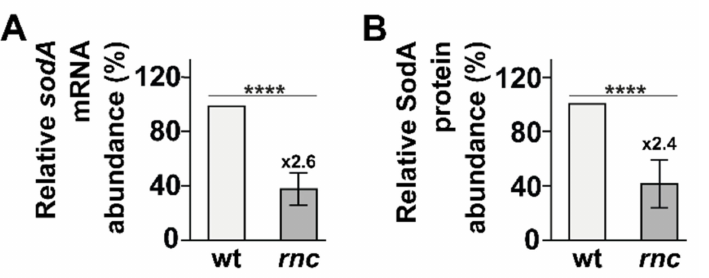
Figure 5. RNase III positively controls sodA expression. Total RNA and protein were sampled from strains wt and rnc and analyzed by ( A ) northern blot (see Figure S6) and ( B ) Western blot (see Figure S7). ( A ) Mean sodA mRNA levels and ( B ) mean SodA protein levels are shown. Values are means of 3 biological replicates and error bars are standard deviations. Statistical significance was determined by ANOVA (**** for p -values ≤